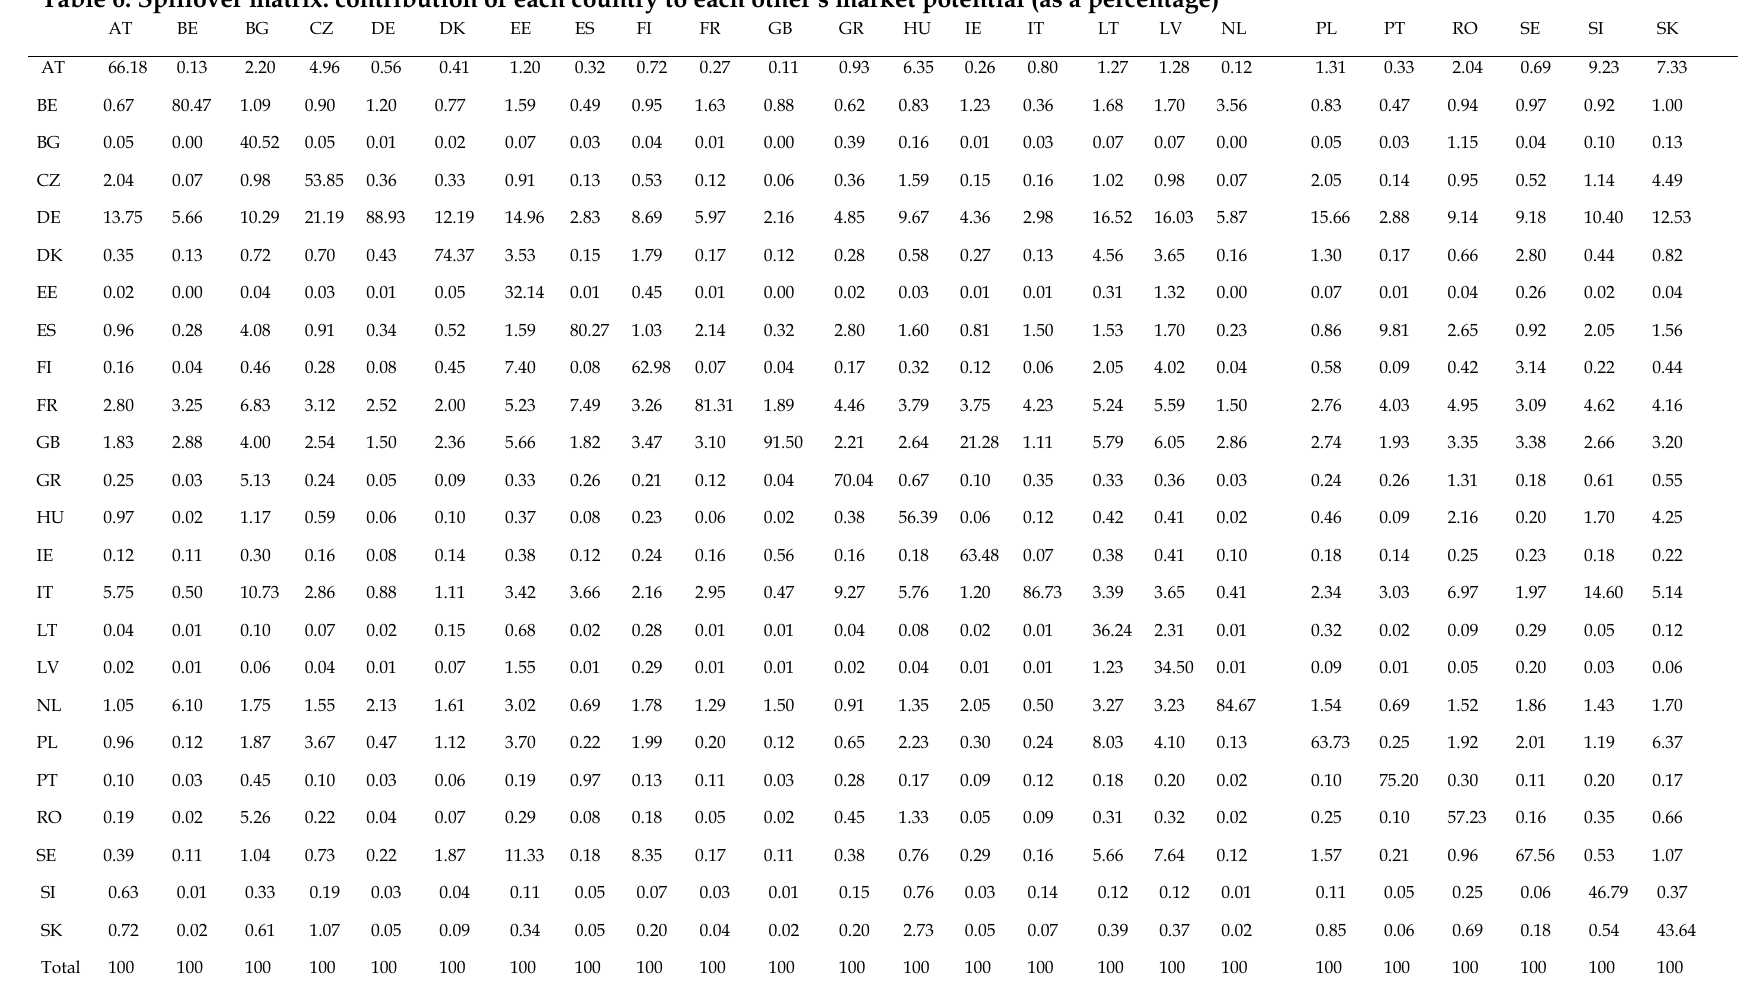
Table 6. Spillover matrix: contribution of each country to each other’s market potential (as a percentage)